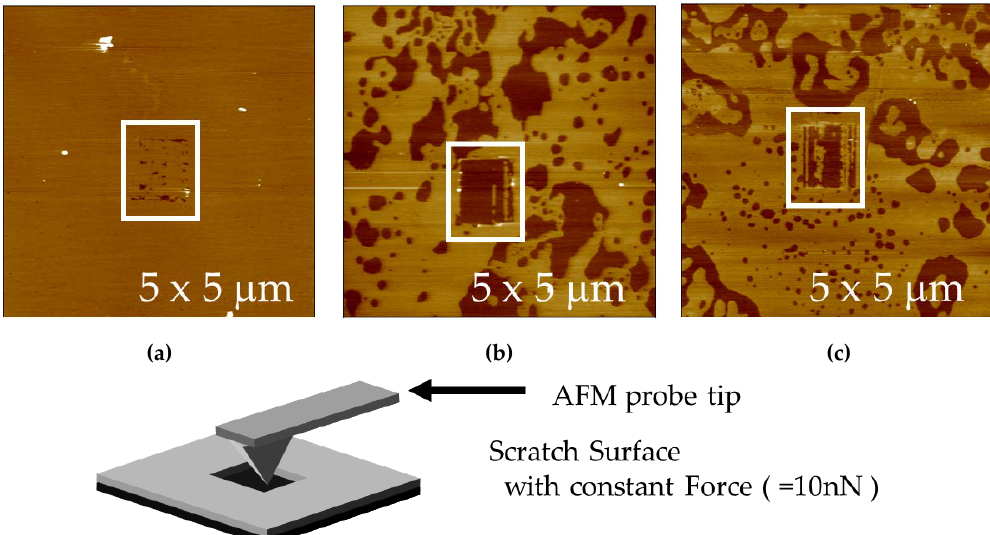
Figure 6. AFM height image of adsoeped layer on mica surface. Dark areas are mica without sorption. Bright areas are sorped layer from conditioner. The white squares indicate where 1000 nm × 1000 nm scratching test were done. ( a ) 18-MEA/SPDA. ( b ) 18-MEA/DAPS. ( c ) 18-MEA/STAC.